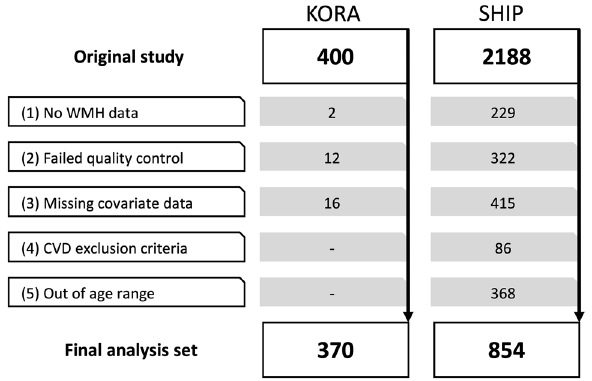
Figure 2. Participant flow diagram of the KORA sample and SHIP sample. (1): Missing WMH volume data or visible lesions with other aetiology. (2): Insufficient image quality (3): KORA: missing visceral or hepatic fat measurements. SHIP: missing OGTT. (4): CVD exclusion criteria were prior myocardial infarction, stroke or revascularization. KORA participants fulfilling these criteria were not eligible for MRI by study design 26 . For consistency between the two studies SHIP participants fulfilling these criteria were excluded. (5): KORA-MRI participants were between 39 and 73 years old by study design 26 . For consistency SHIP participants outside this age range were